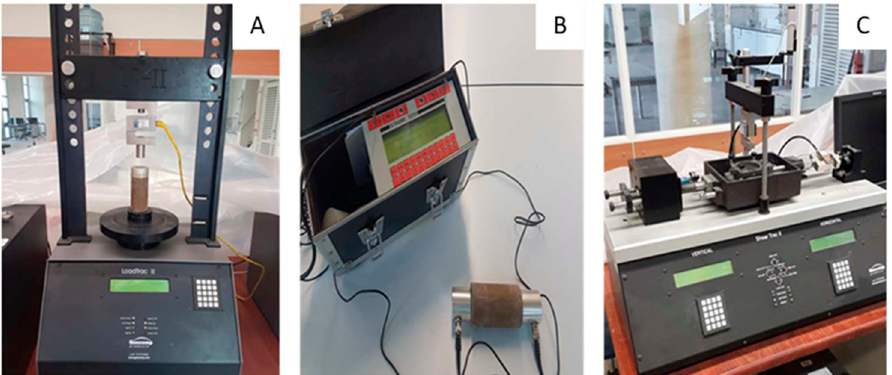
Figure 3. Tests setups; ( A ) load Frame for UCS, ( B ) Pundit for Ultrasonic Pulse Velocity (UPV), and ( C ) direct shear box for shear strength parameters.